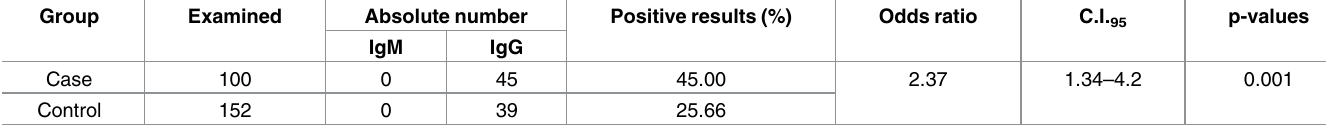
Table 2. Comparative prevalenceof immunoglobulins M and G to Toxoplasma gondii in the experimental group and the control group.